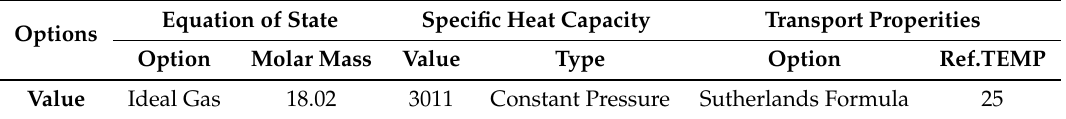
Table 5. Thermodynamic Properties in ANSYS-CFX material properties.